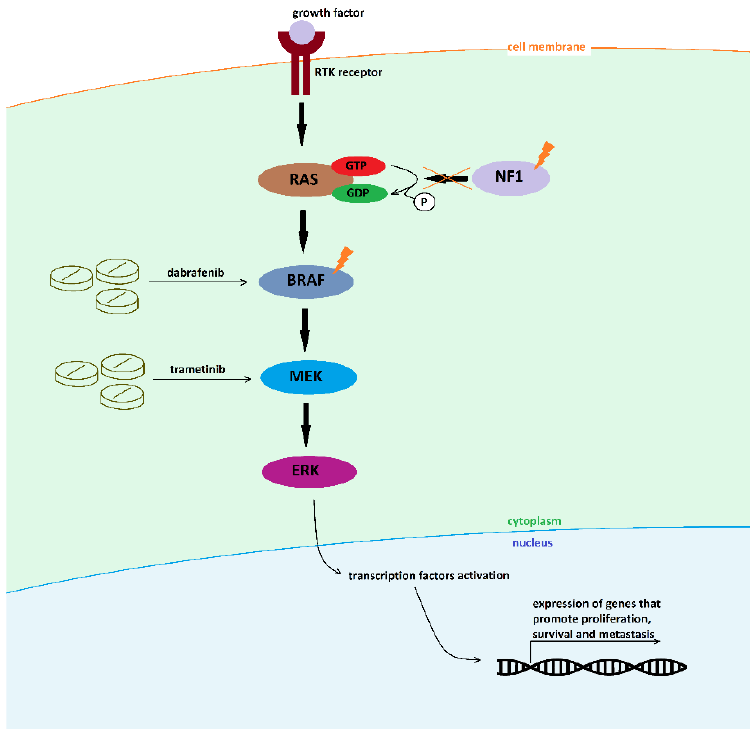
Figure 1. Scheme of the signal transduction pathway involving BRAF and NF1.